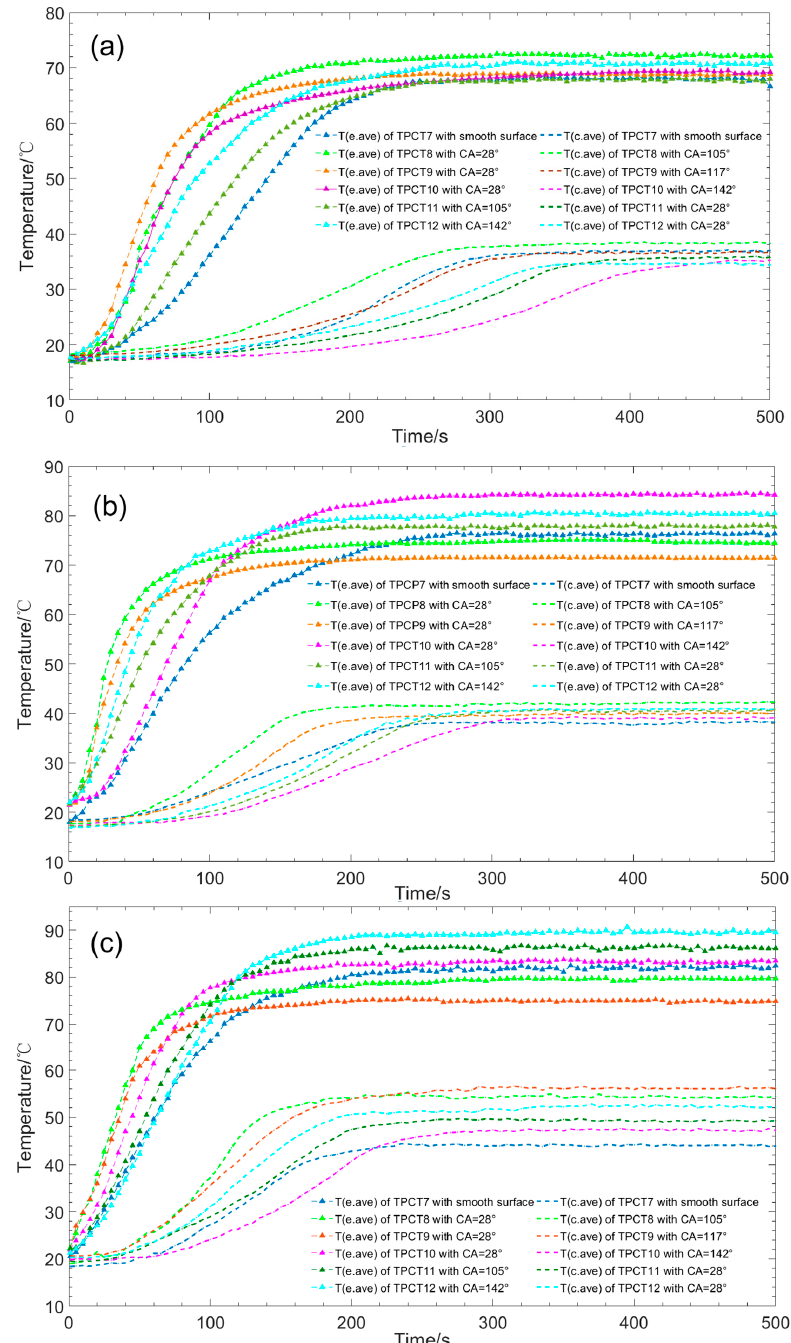
Figure 9. Start-up performances of TPCT7 (smooth surface) and TPCT8–TPCT12 with combined hydrophilic and hydrophobic properties at di ff erent heat input powers: ( a ) Q in = 40 W;( b ) Q in = 60 W; ( c ) Q in = 80 W .